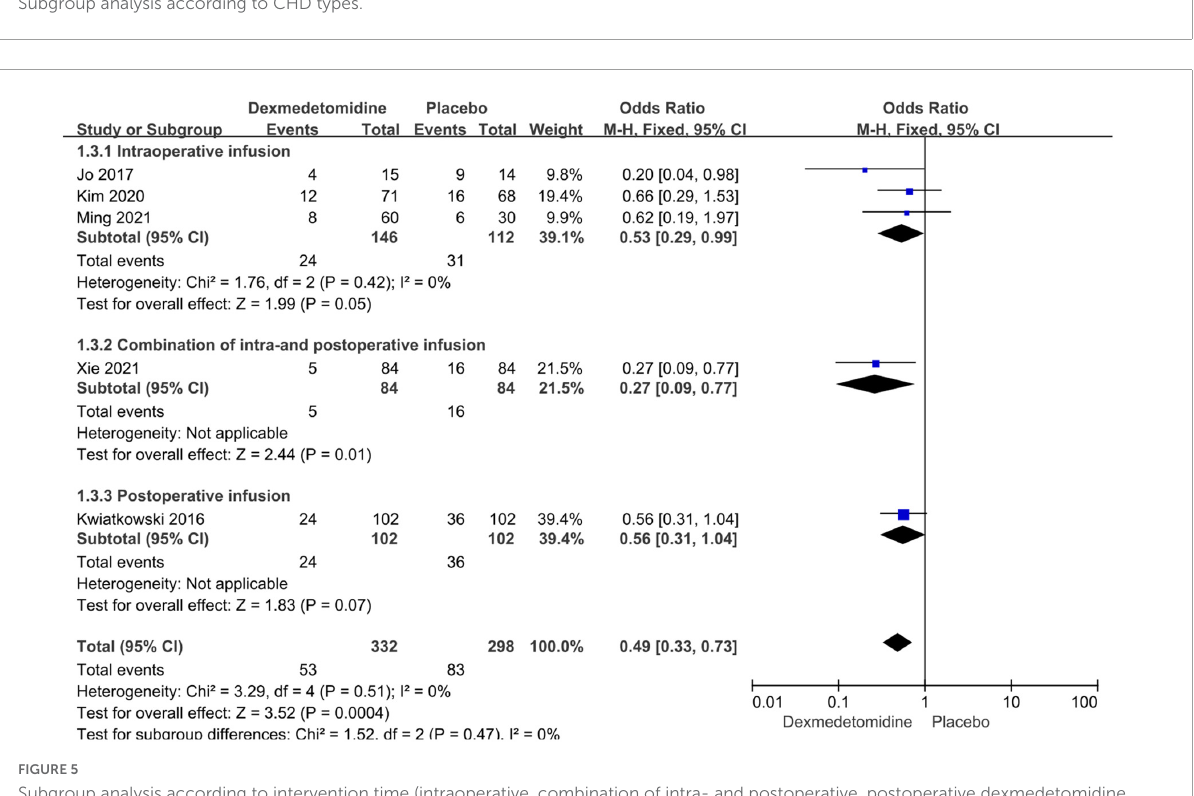
FIGURE4 Subgroup analysis according to CHD types.